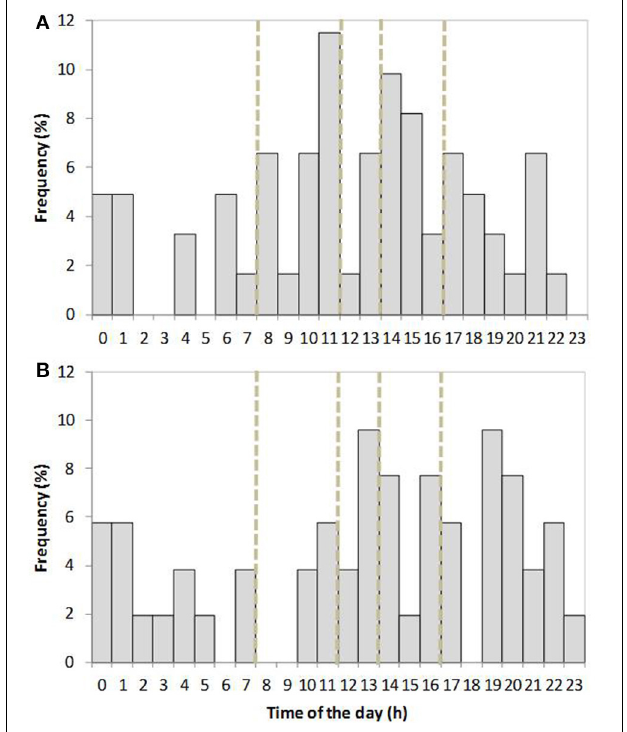
FIGURE 2 | Distribution of the onset of farrowing over the circadian period in old-type (A) and modern-type (B) sows. Periods of staff working hours are indicated with doted lines (8–12 a.m. and 2–5 p.m.), data from the first and second parities are grouped